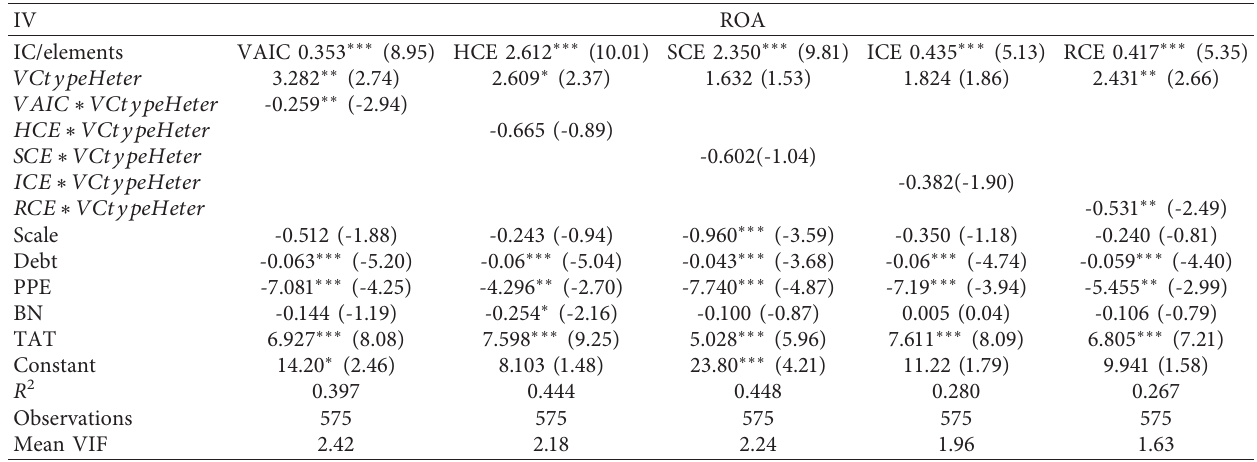
Table 8: Moderating effect of VCS member heterogeneity.